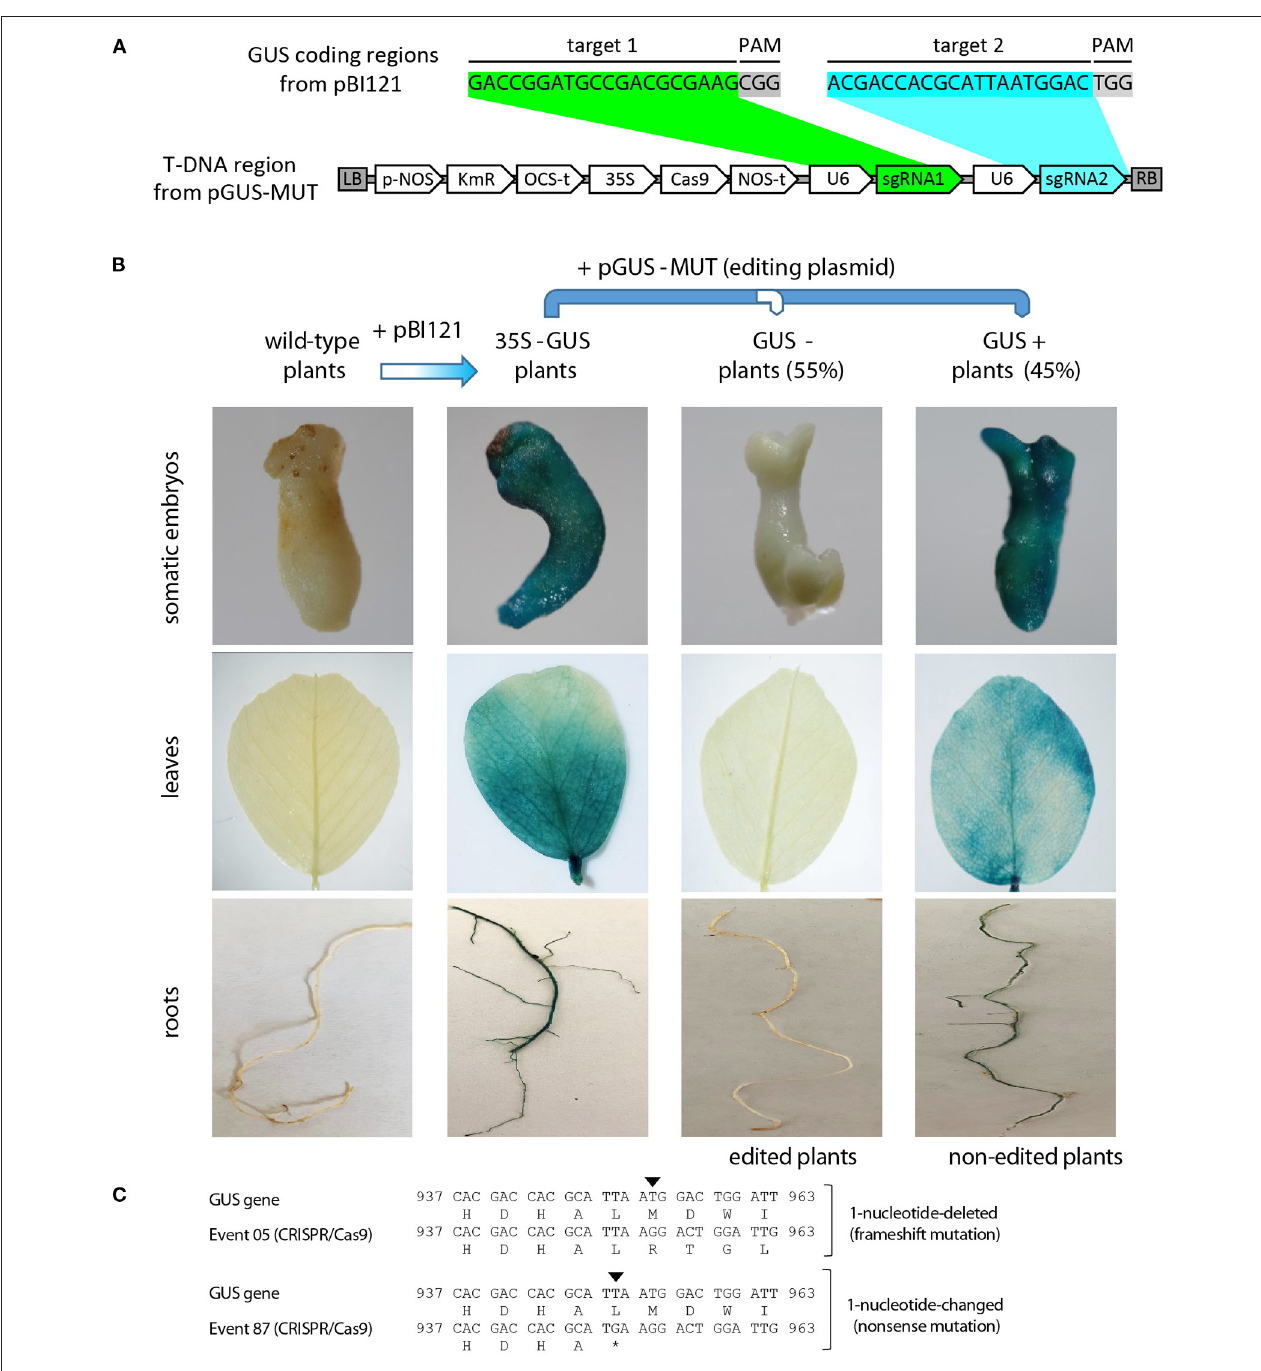
FIGURE 1 | High-efficiency alfalfa mutagenesis by using regenerative alfalfa clone C23 and the CRISPR/Cas9 system. (A) Above: Schematic representation of a fragment of the GUS coding sequence from the binary vector pBI121 used to produce transgenic alfalfa with high GUS activities, specifically showing the sequence targeted by the sgRNA (target 1 and target 2) and the sequence recognized by the Cas9 nuclease (PAM sequences). Below: Schematic representation of the T-DNA region from the binary vector p GUS -MUT used for the CRISPR/Cas9-mediated knockout of GUS reporter. In the last vector, the nopaline synthase (pNOS), the Arabidopsis thaliana U6 (U6), and the CaMV 35S promoters were used to drive the constitutive expression of the NPTII gene for kanamycin selection in planta (KmR), a plant codon-optimized Cas9 gene for genome editing in dicots (Cas9) and two sgRNA (sgRNA1 and sgRNA2) that targeted in two regions (target 1 and target 2) of the GUS gene. The octopine synthase (OCS-t) and nopaline synthase (NOS-t) terminators within the T-DNA region are shown. (B) Representative images of GUS activity in somatic embryos and leaves of alfalfa clone C23 without synthetic elements (wild-type plants), alfalfa clone C23 containing the GUS reporter from pBI121 (35S- GUS plants), and importantly, GUS -positive ( GUS + ) and GUS -negative ( GUS -) plants derived from 35S- GUS plants transformed with the CRISPR/Cas9 system for GUS edition from p GUS -MUT. As described in the text and summarized in this picture, around half of the 35S- GUS plants transformed with the Cas9 nuclease